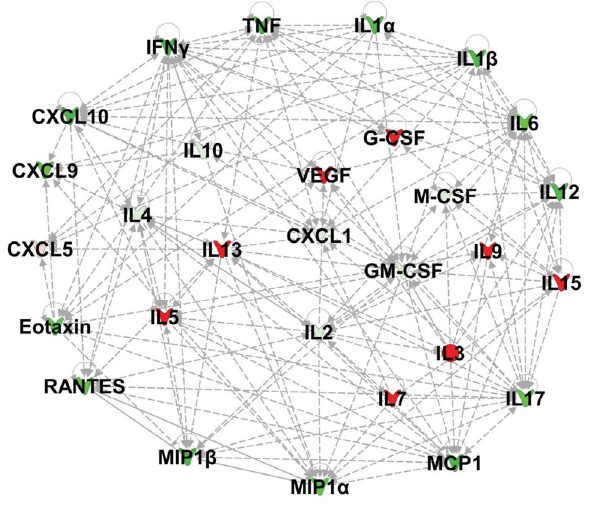
Figure 5. Atorvastatin regulated gene network of pro-inflam- matory, anti-inflammatory and growth factors. Red-labeled genes were up-regulated and green-labeled genes were down- regulated in Atorvastatin-treated compared with saline-treated mice on day 11 of P. berghei ANKA infection. Color intensity signifies the degree of regulation. White labeled genes were not represented in the uploaded data set, but their connectivity was determined through network analysis.